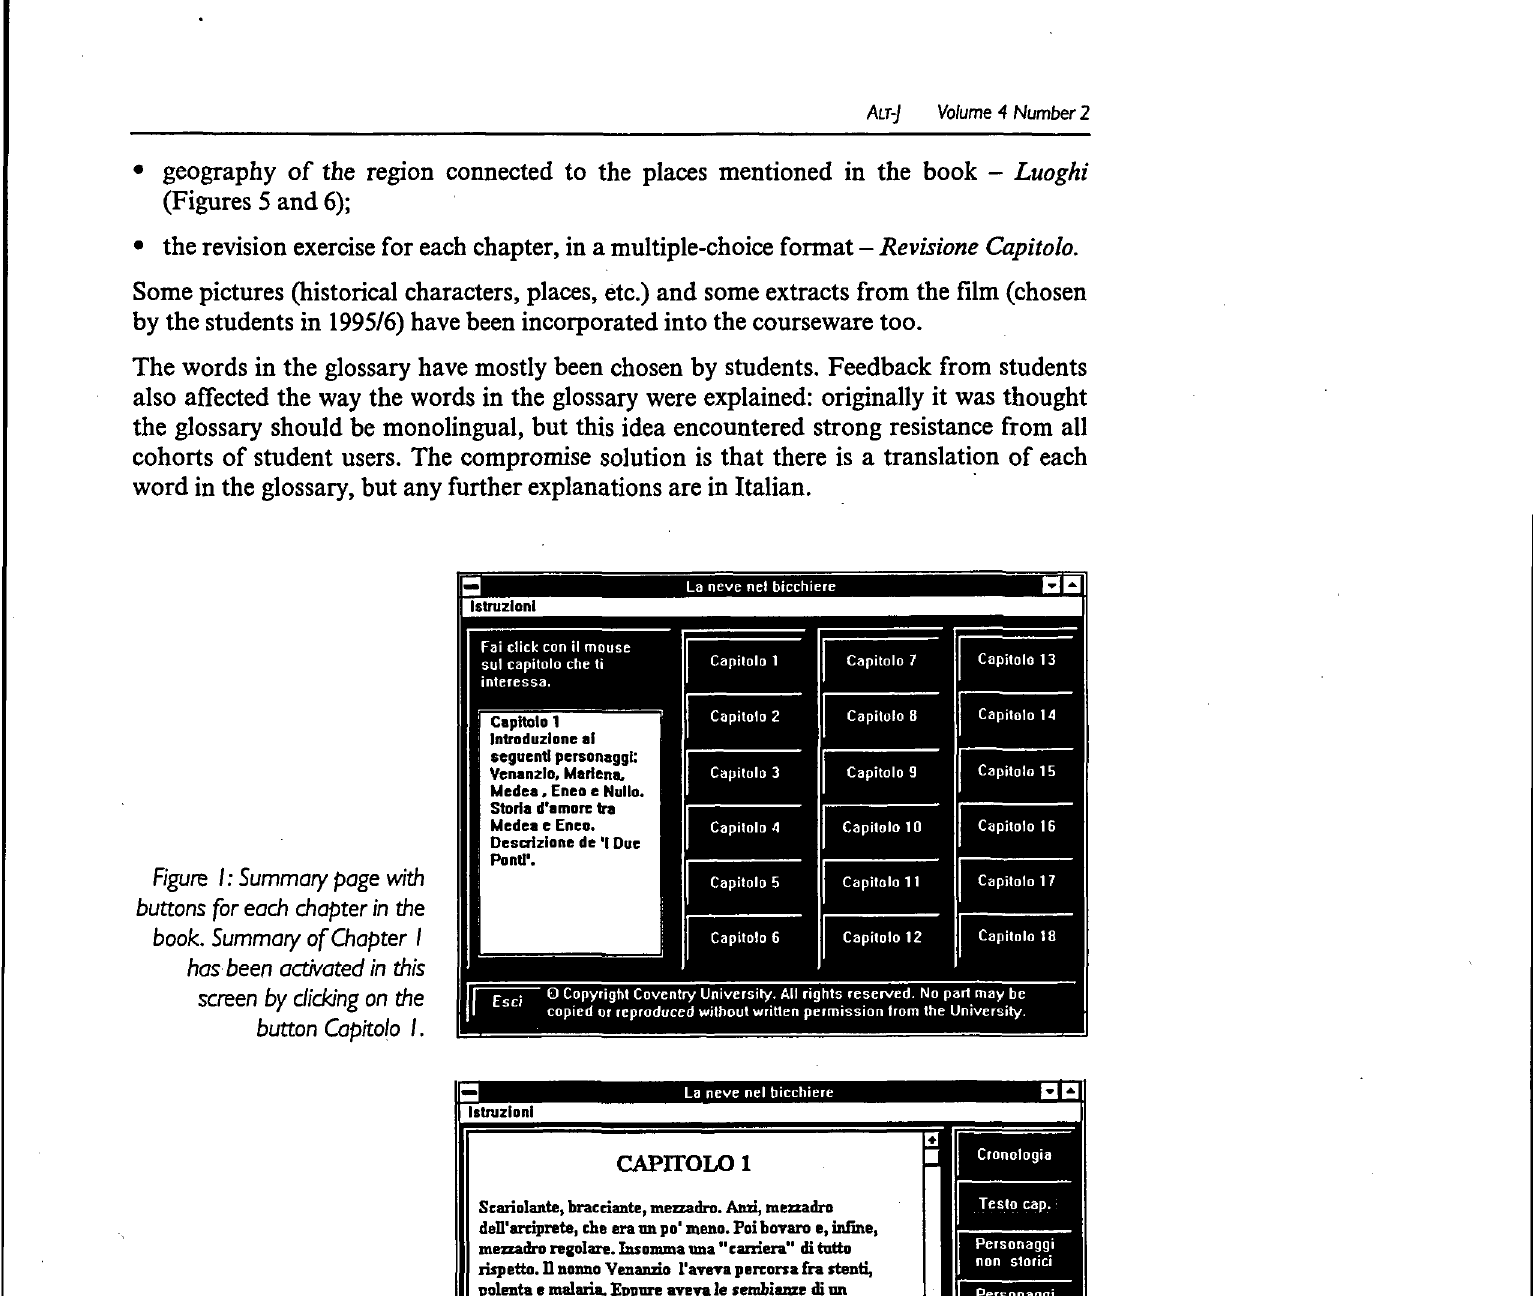
Figure 2: Screen with part of the text for Chapter I: this is the main starting point for navigation into